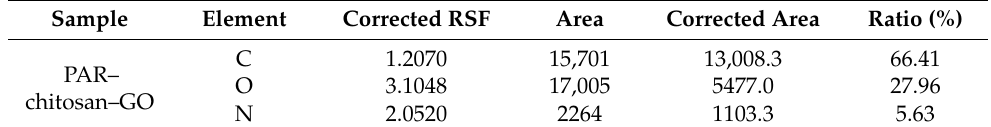
Table 1. Elemental composition of the PAR–chitosan–GO thin film. RSF, relative sensitivity factor.